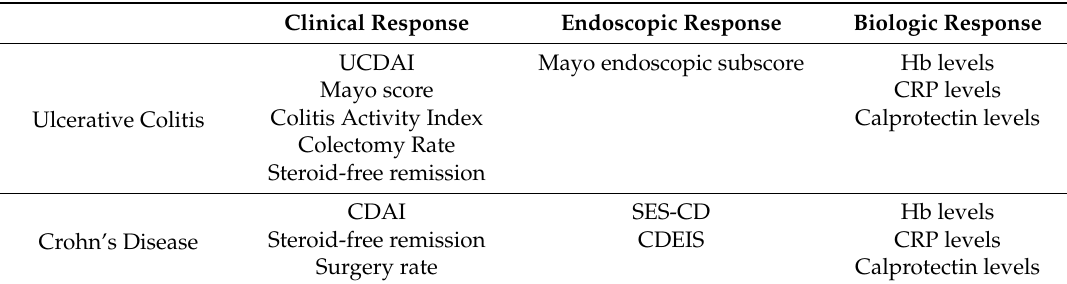
Table 1. Different parameters used for response assessment to anti-tumor necrosis factor (TNF)- α agents in ulcerative colitis and Crohn’s